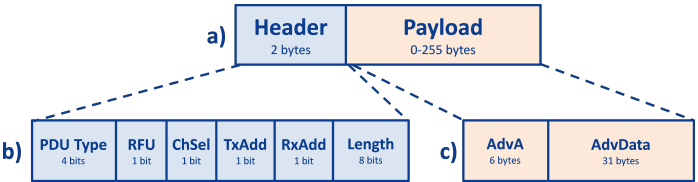
Figure 10. PDU structure of an advertising packet. In ( a ) the first two bytes represent the Header, while the other bytes are the effective payload of the packet. The Header, showed in detail in ( b ), is composed of 4 bits of the PDU Type, 1 bit of RFU, 1 bit of ChSel, 1 bit of TxAdd, 1 bit of RxAdd